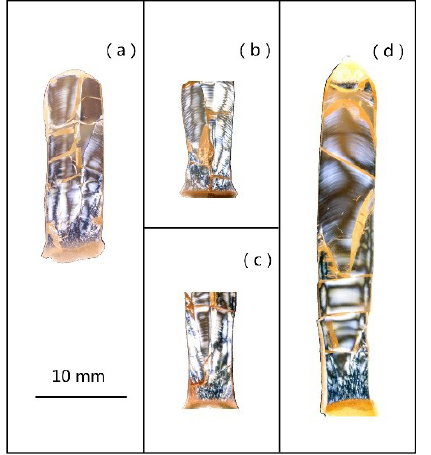
Figure 2. Polariscopic photographs of slices cut from the central part of as-grown Y 2 Ti 2 O 7 crystals. ( a ) For sample # 1, ( b ) for sample #2, ( c ) for sample #3, and ( d ) for sample #4.